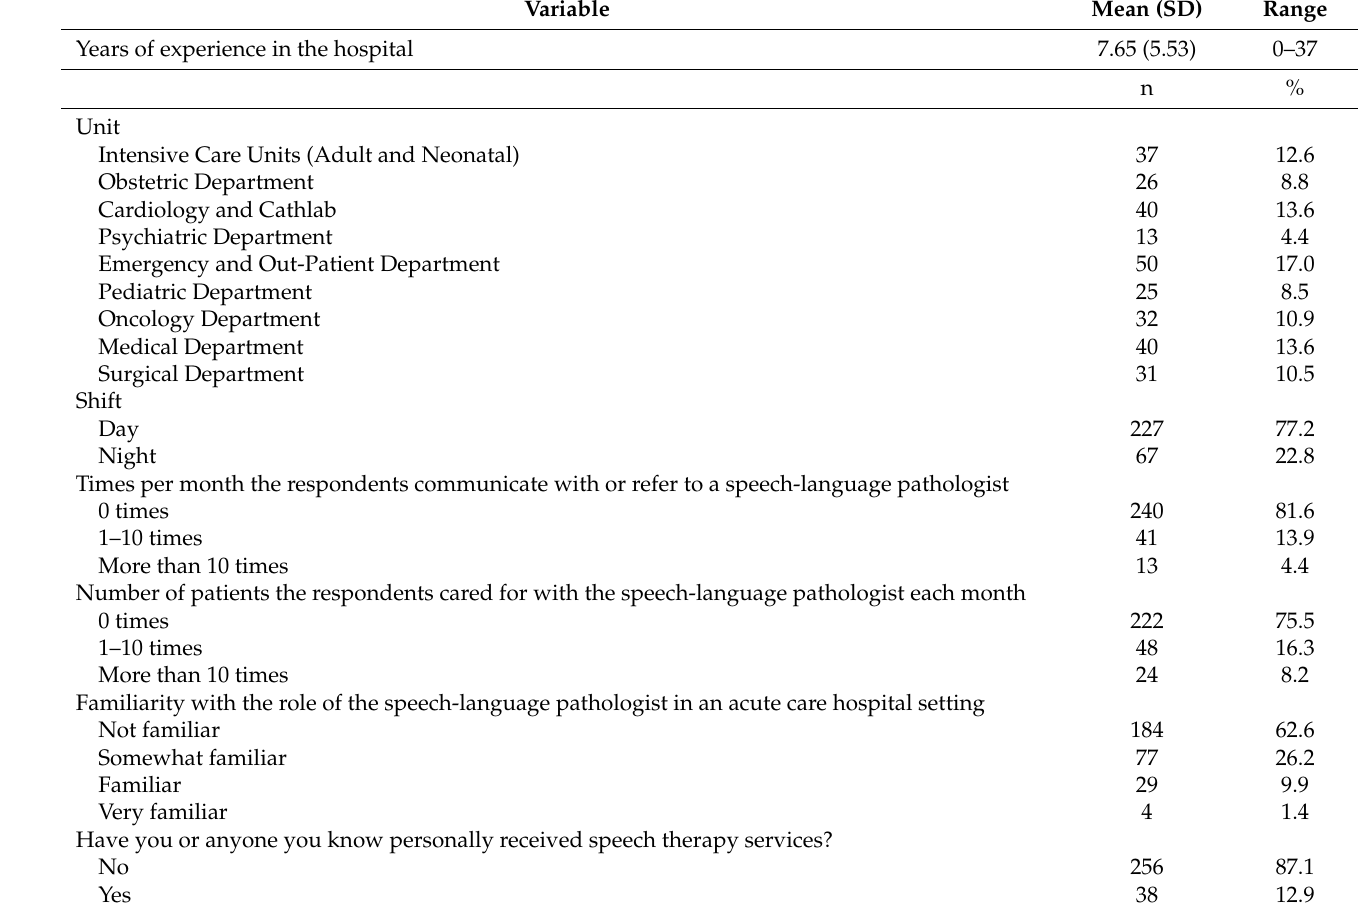
Table 1. Work-related Characteristics of the Participants (N =